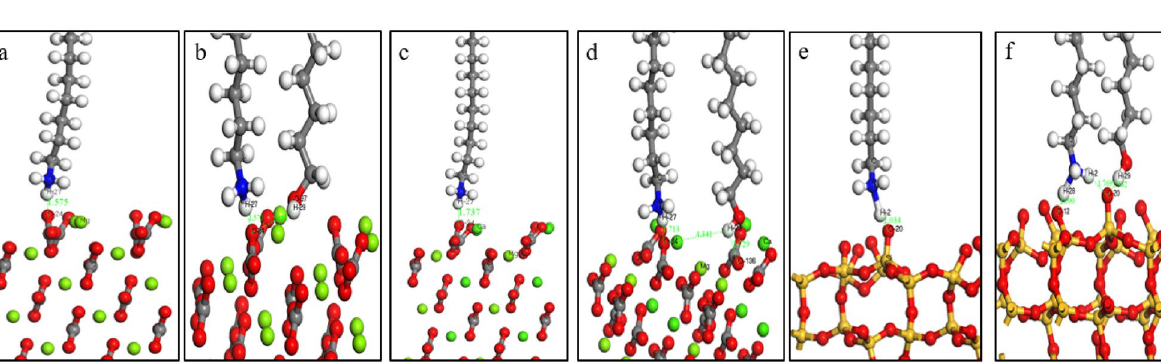
Figure 4. Geometric adsorption structure of DDA ( a , c , e ) and NDA ( b , d , f ) on the surface of magnesite (101) ( a , b ), dolomite (101) ( c , d ) and quartz (101) ( e , f